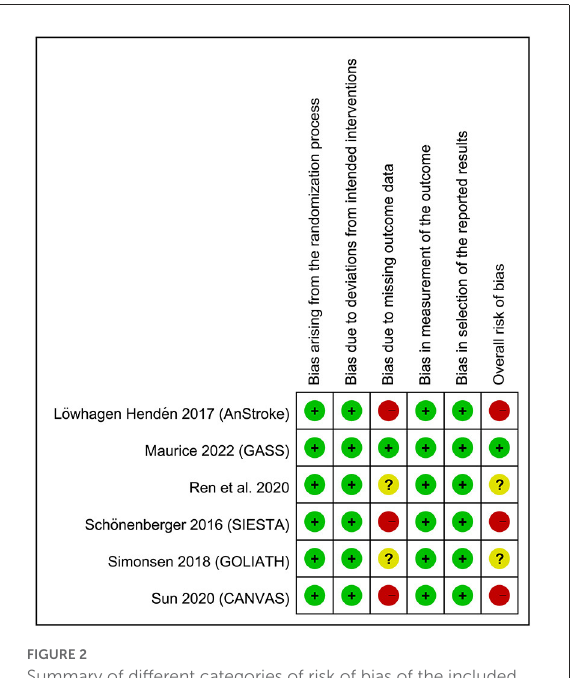
FIGURE2 Summary of different categories of risk of bias of the included studies. Green: low risk of bias; yellow: moderate risk of bias; red: high risk of